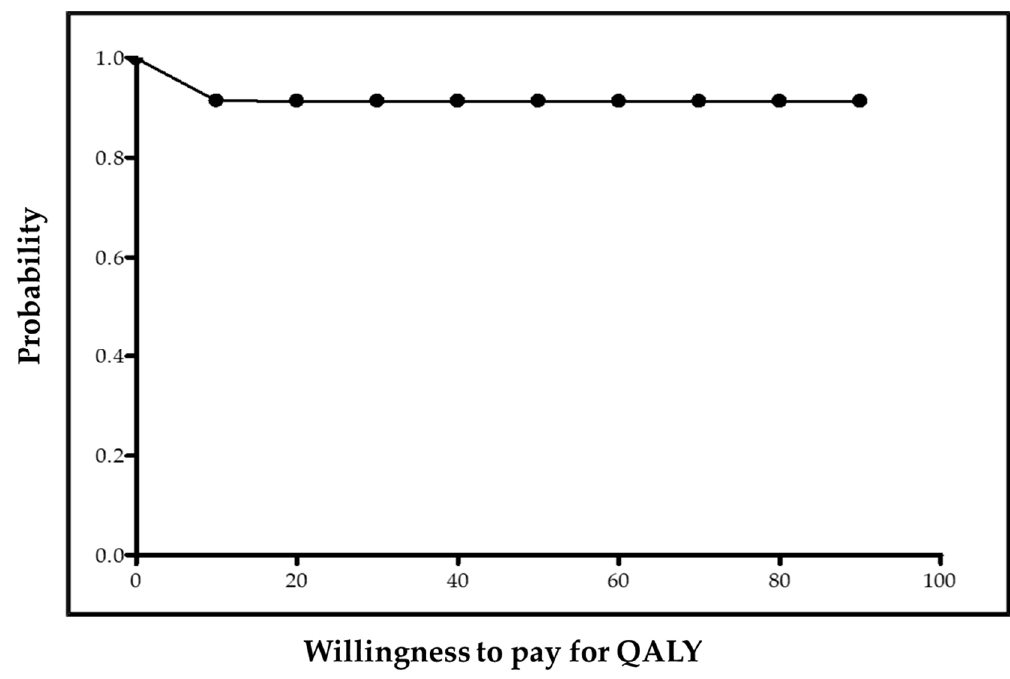
Figure 4. Cost-e ff ectiveness acceptability curve. The curve shows the cost-e ff ectiveness probabilities Figure 4. Cost-effectiveness acceptability curve. The curve shows the cost-effectiveness probabilities for PUNCH by di ff erent degrees of willingness to pay for wound-free for PUNCH by different degrees of willingness to pay for wound-free day.